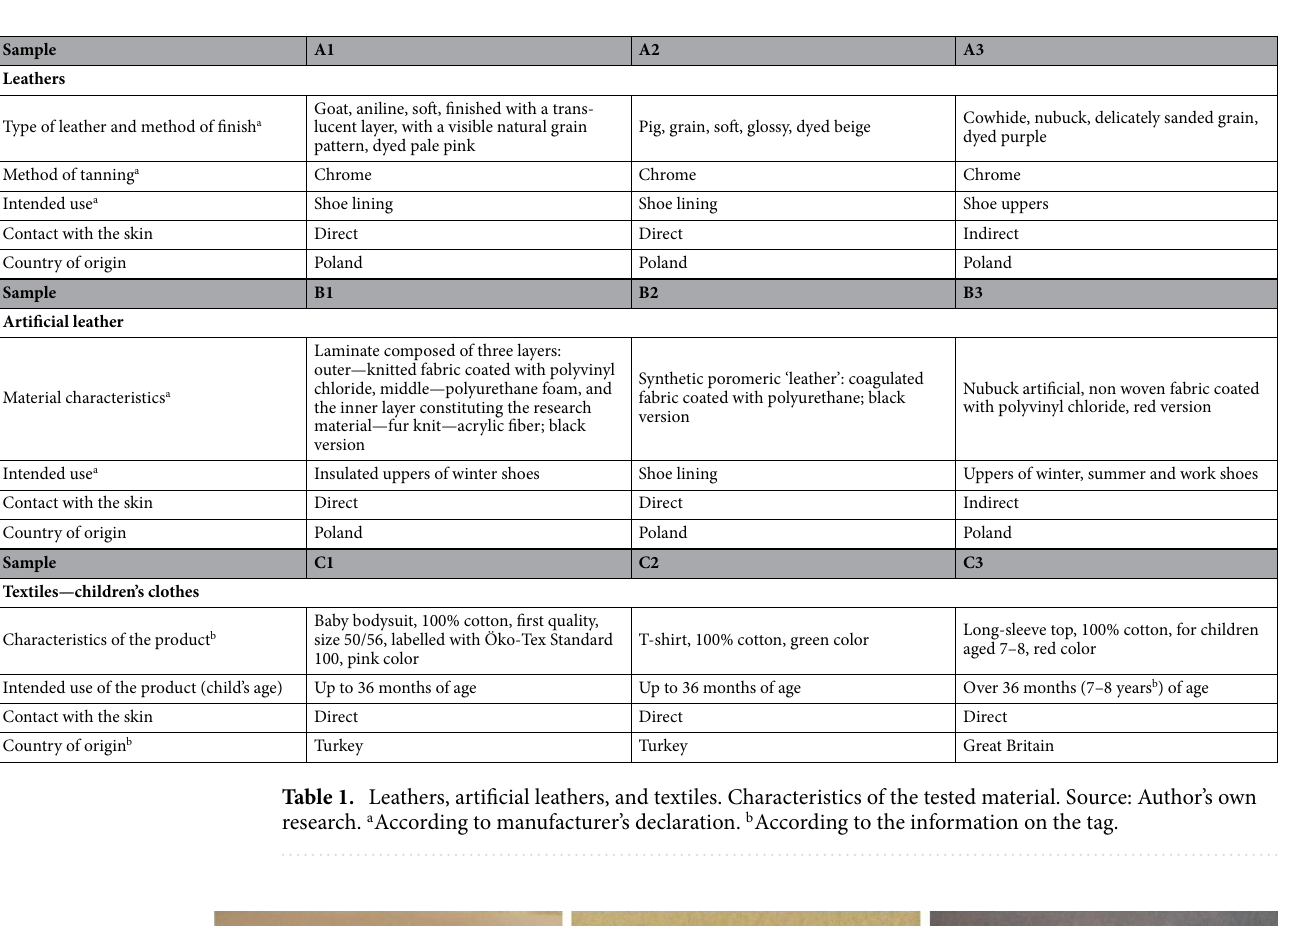
tion to ICP. For the tests, the same procedure for sample preparation, metal extraction and metal determination with AAS was adopted for all the materials, i.e., leathers, artificial leathers, and textiles. Sampling, grinding, and drying of samples to a constant mass. Laboratory samples of leathers (A1, A2 and A3) were taken from butts following the guidelines of the ISO 2418 standard 37 , artificial leathers (B1, B2 and B3)—from the central part of a sample with an area of 200 × 150 cm, while textiles (C1, C2 and C3)— from the sleeves of children’s clothes (baby bodysuit, T-shirt and top). Next, the samples were ground in accord- ance with the guidelines of the ISO 4044 standard 38 and placed in weighing vessels, dried and weighed with an